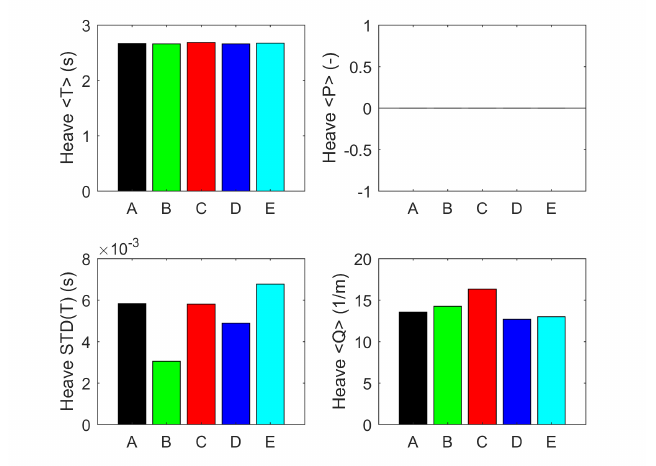
Figure 7. Heave natural periods ( left ), linear and quadratic damping estimates ( right